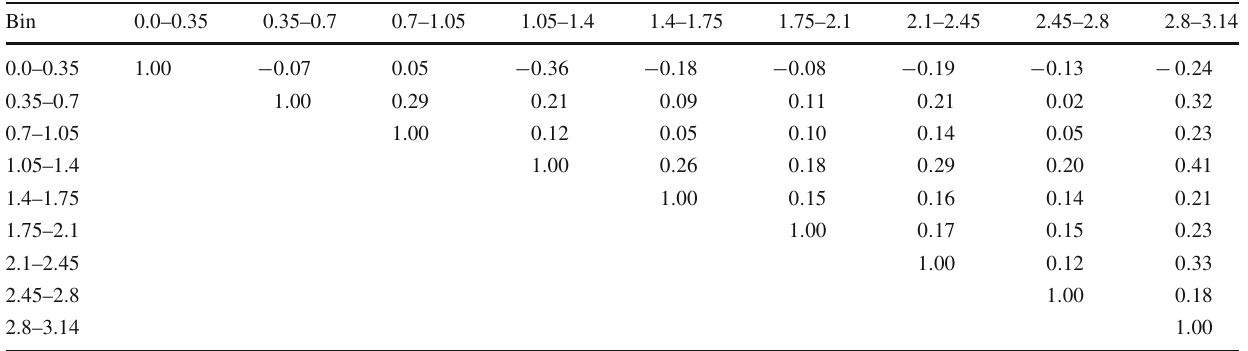
Table 6 The correlation matrix for the normalzed differential cross-section as a function of (cid:7)φ((cid:8),(cid:8)) in the dilepton channel, accounting for the statistical and systematic uncertainties Bin